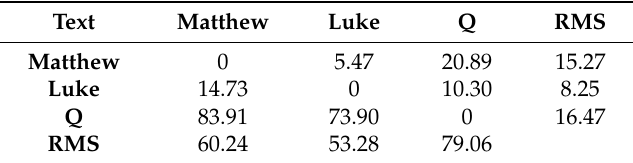
Figure 15. Own Tradition. Probability density functions (upper panel) and probability distribution functions (lower panel) of the number of interpunctions per sentence M F . Matthew : green line; Luke : blue line; Q : cyan line. Table 15. Own Tradition and Q. Kolmogorov–Smirnov test results for I P (below the diagonal of zeros) and M F (above the diagonal). The values reported are the confidence level (%) that the indicated couple of probability distributions are not identical.